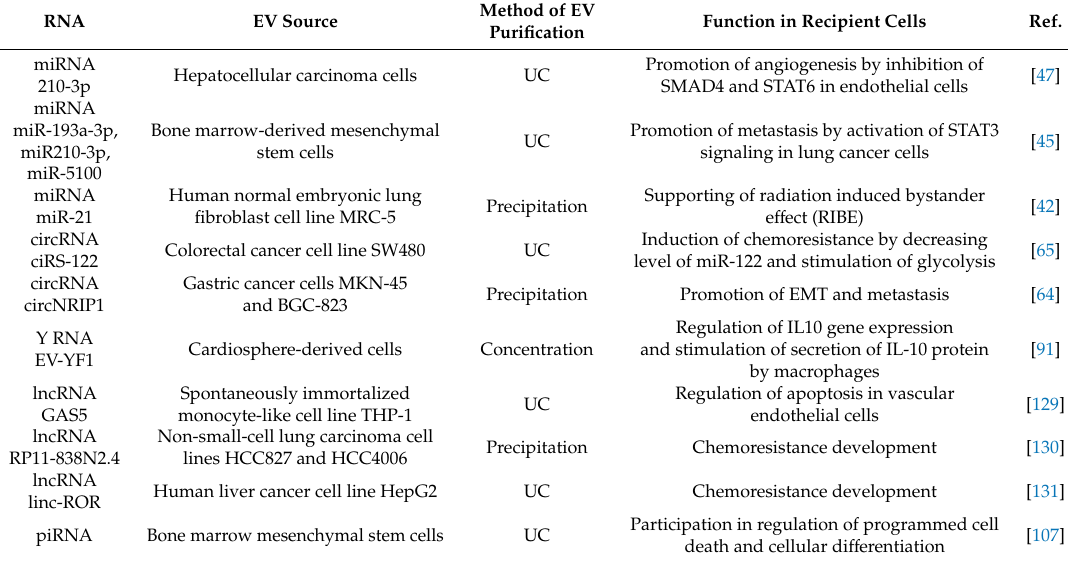
Table 1. Selected examples of non-coding RNAs identified in small extracellular vesicles with the recognized function in recipient